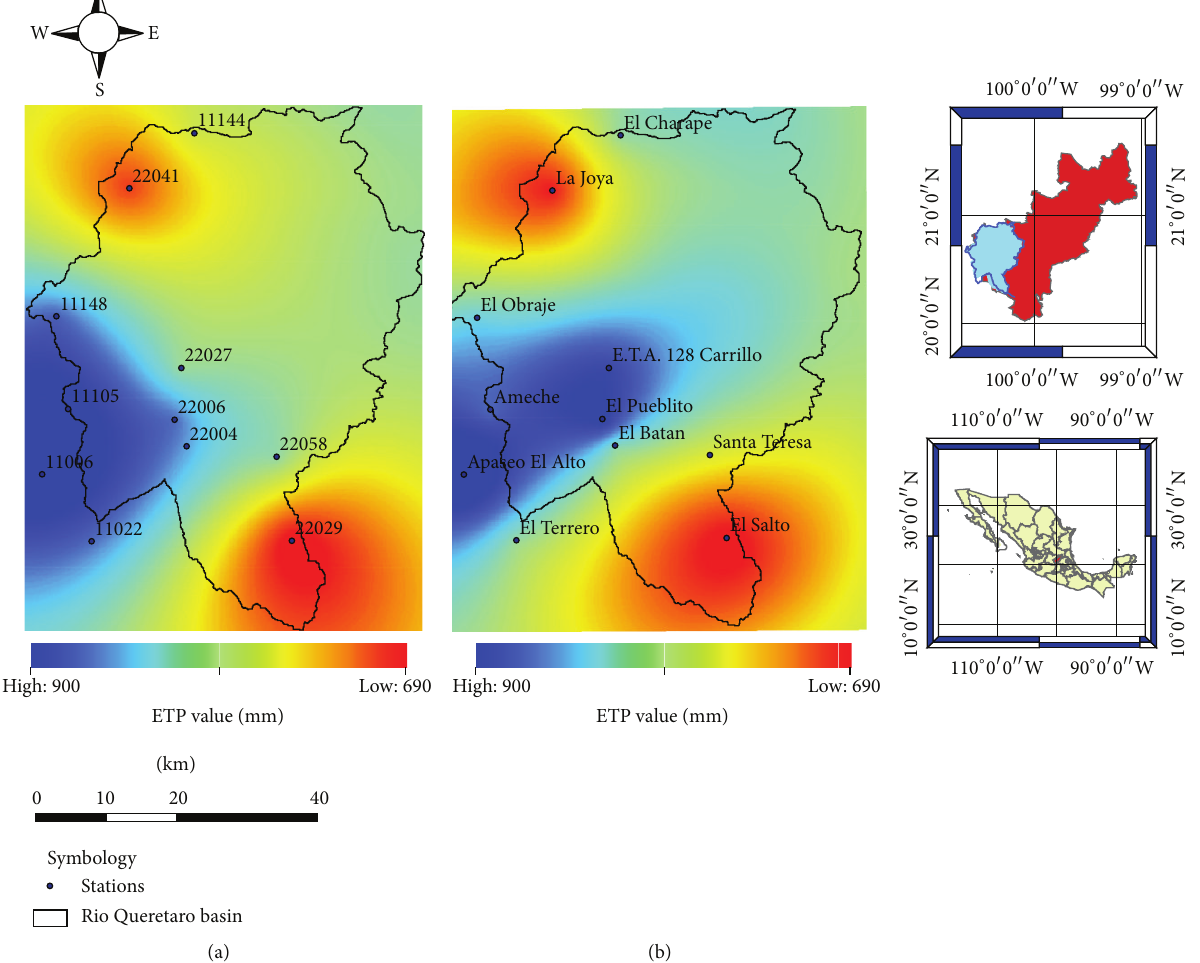
Figure 8: Spatial distribution of potential evapotranspiration calculated by the Thornthwaite method with observed and reconstructed temperature